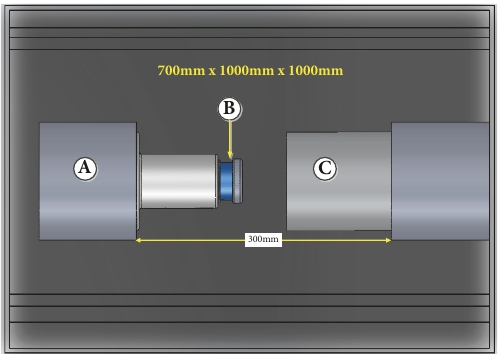
Figure 1: The schematic diagram of part